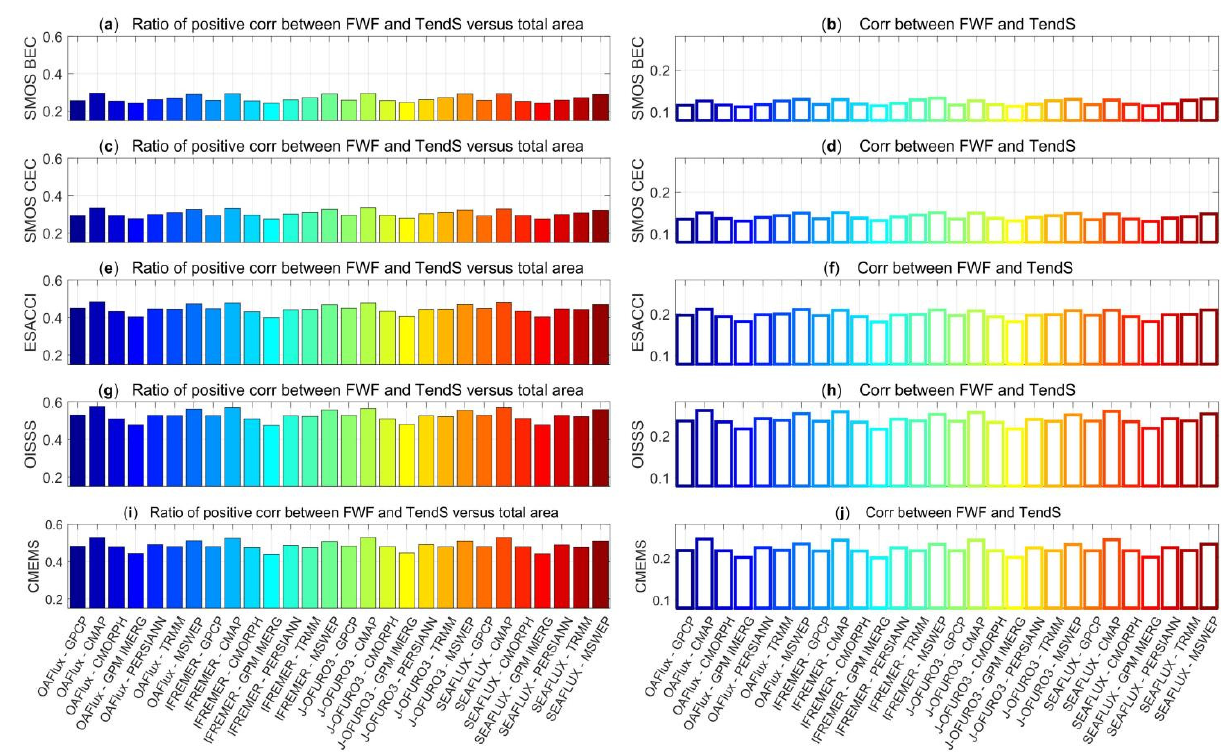
Figure 7. ( a ) Ratio of the spatial coverage of significant and positive correlation between SMOS SSS tendency and 28 sets of FWF versus total size of global ocean over 50°S–50°N and ( b ) area-weighted correlation coefficients. The correlation coefficient is calculated between 28 sets of FWF and ( c , d ) ESA CCI, ( e , f ) OISSS, and ( g , h ) CMEMS. The hollow bars in ( b , d , f , h , j ) indicate p -value is larger than 0.05. From dark blue to light blue bars indicate combinations between OAFlux and seven precipitation datasets; from cyan to bright green bars denote combinations between IFREMER and seven precipitation datasets; from light green to orange bars indicate combinations between J-OFURO3 and seven precipitation datasets; and from light red to dark red bars represent combinations between SEAFLUX and seven precipitation datasets.